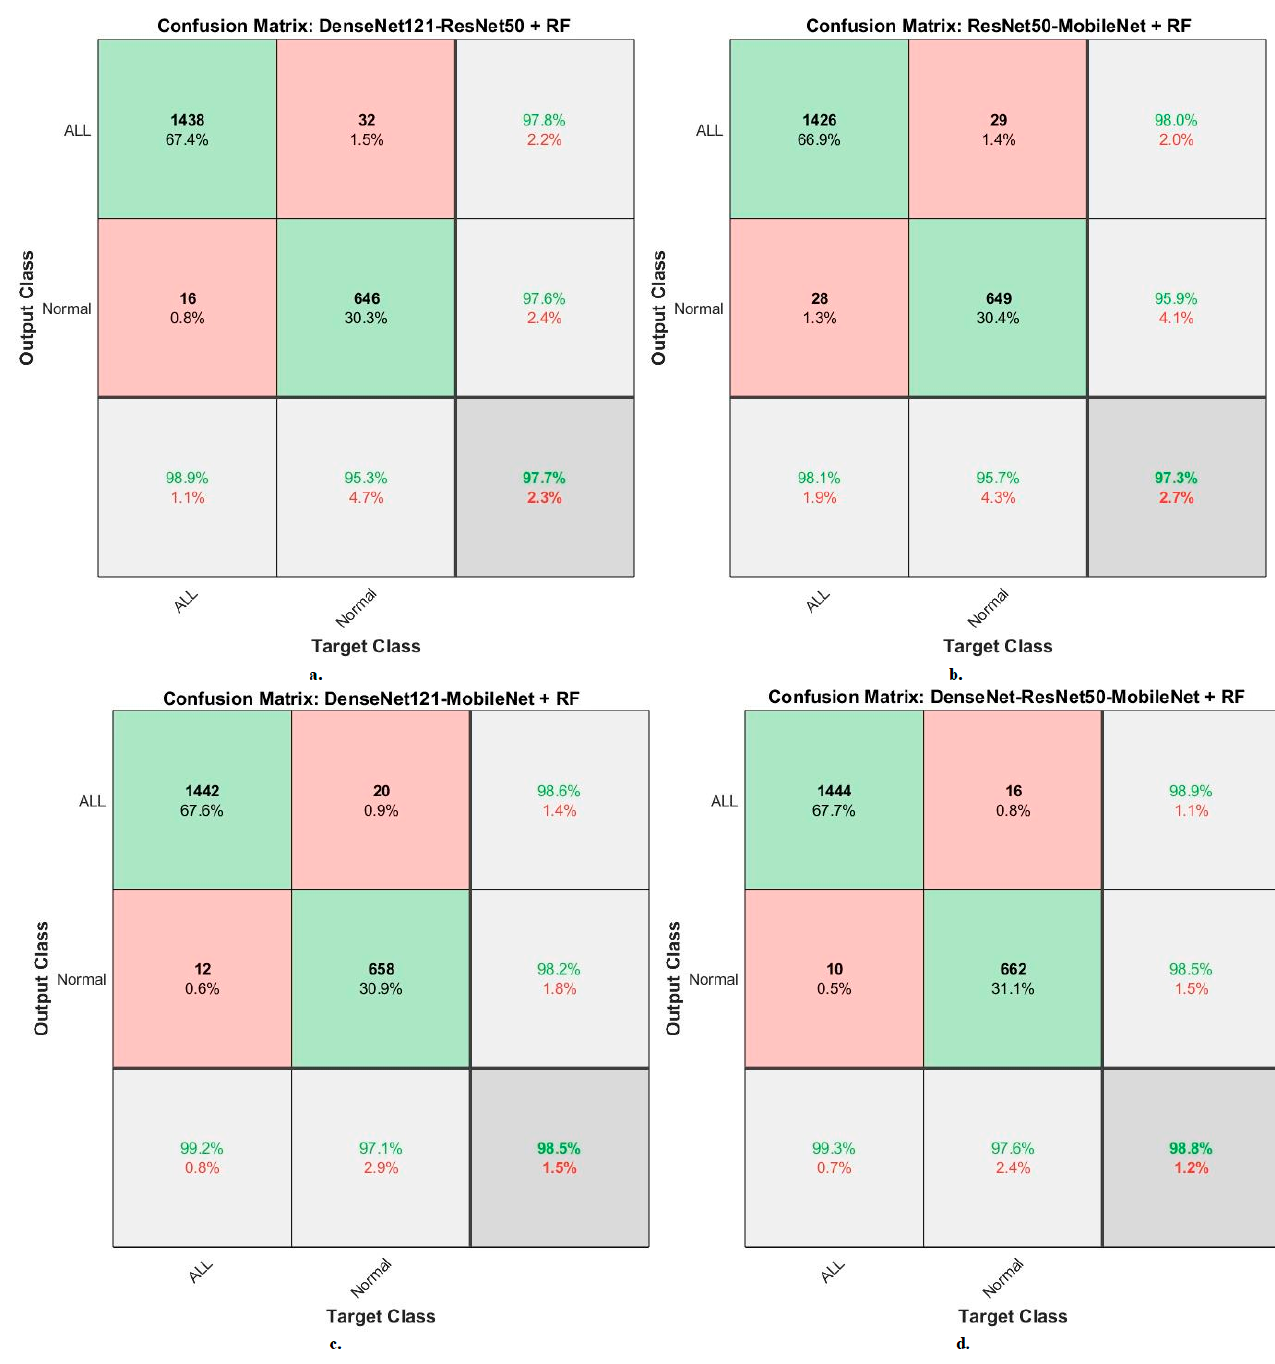
Figure 15. Results of the RF classifier based on fusion features of the CNN models of the C-NMC 2019 dataset for the diagnosis of acute leukemia, confusion matrix of ( a ) DenseNet121-ResNet50, ( b ) ResNet50-MobileNet, ( c ) DenseNet121-MobileNet, and ( d ) DenseNet121-ResNet50-MobileNet.